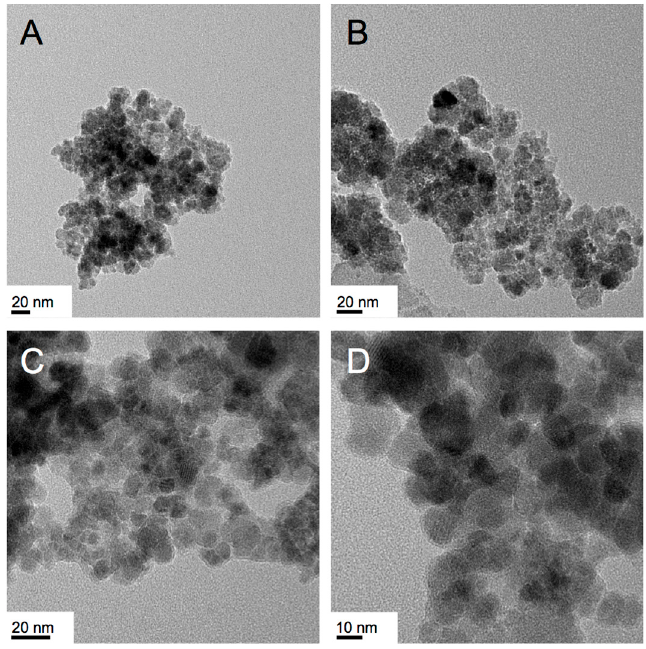
Figure 8. TEM images of the IO nanostructures obtained from the reduction/hydrolysis reaction of Fe(acac) 3 in the Col hI phase formed by CTAB (25 wt %) in water at 25 °C: ( A , B ) froth fraction and ( C , D ) gel fraction (lattice fringes are visible for some of the nanostructures in image ( D )).